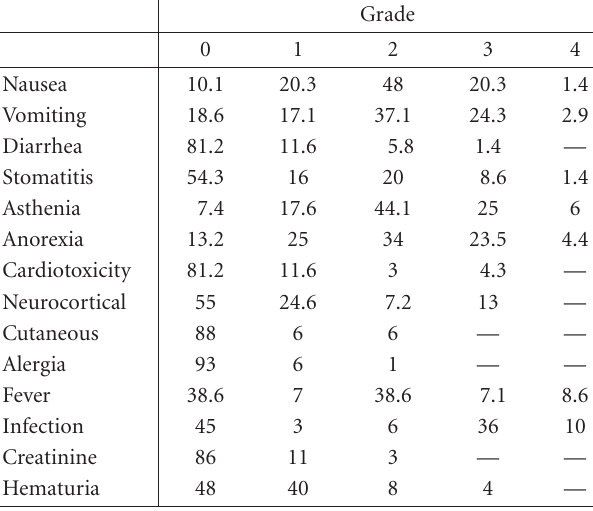
Table 6: Nonhematologic toxicity (% of